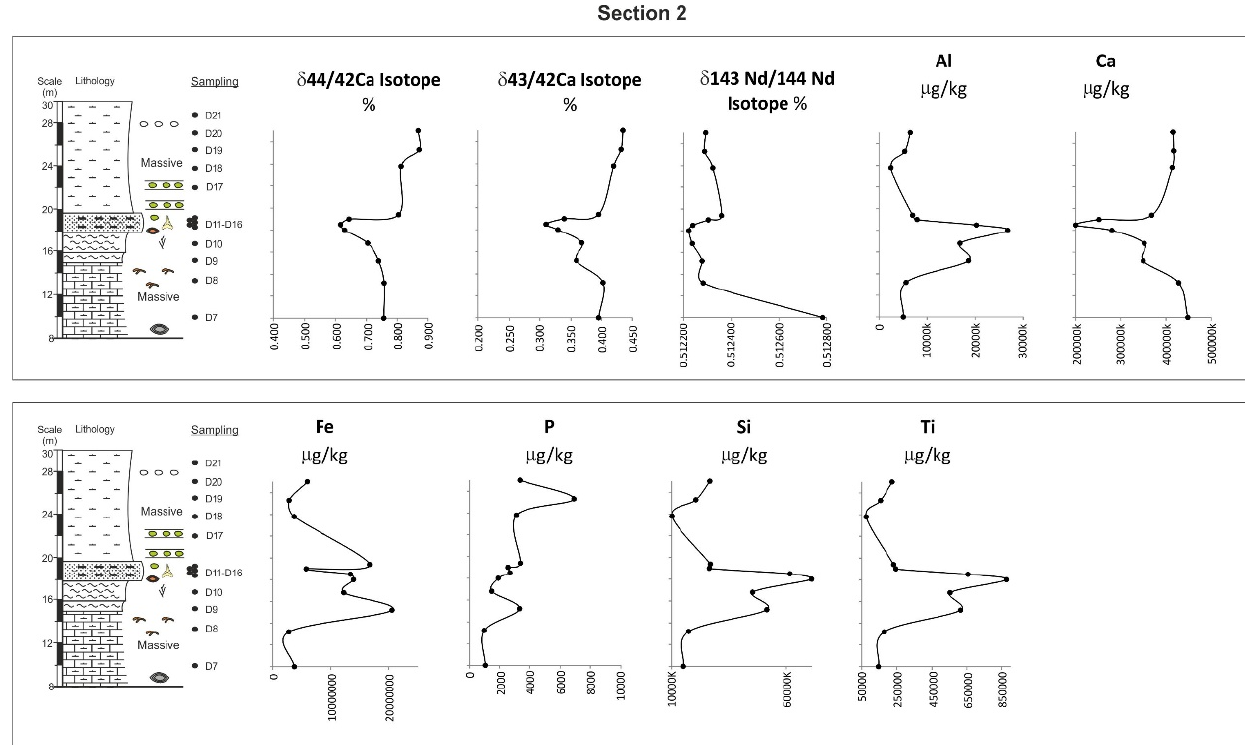
Figure 7. Geochemical data plot against its stratigraphic positions of section 2 samples.